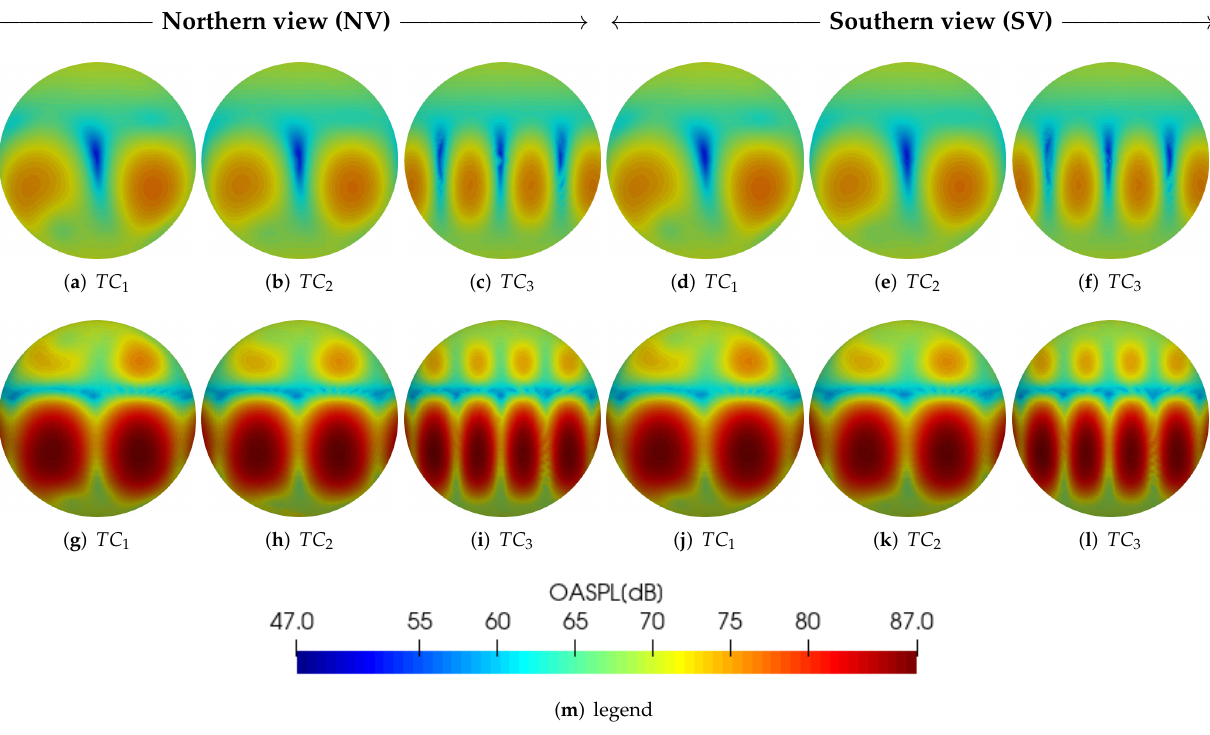
Figure 4. Co-rotating propellers, influence of TC on OASPL, for M t = 0.52 (upper) and M t = 0.7